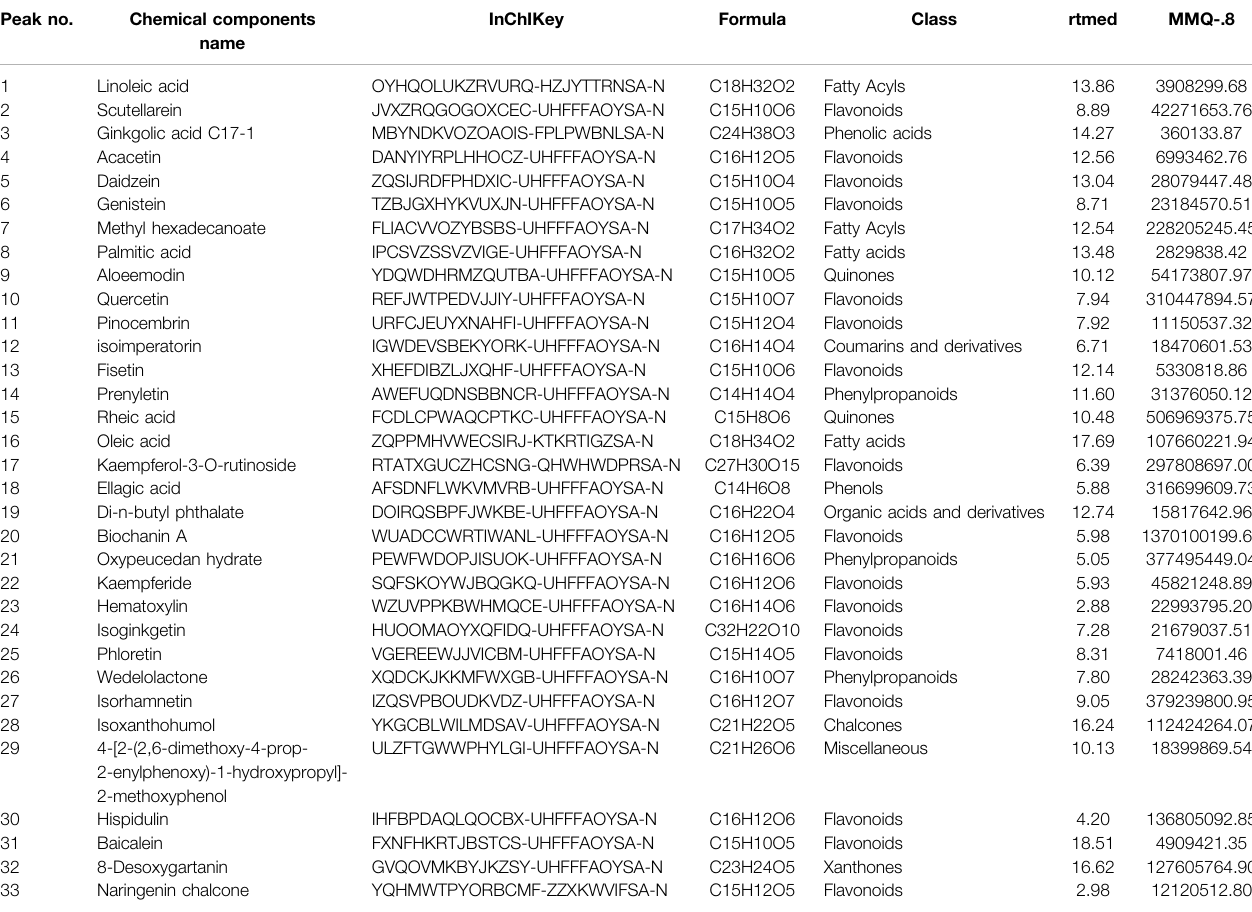
TABLE 3| Thirty-threeMMQ-8 active metabolites have been detected inNEG electrospray ionizationmodes ofUHPLC-QE-MS assayand screened bythe PercentHuman Oral Absorption and drug-likeness values. Peak